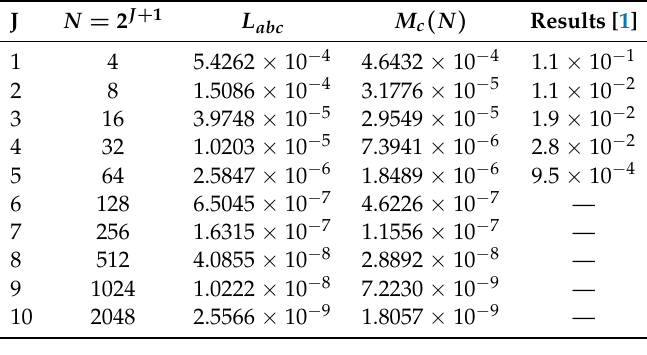
Table 2. L abc and M c ( N ) errors for Test Problem 2.